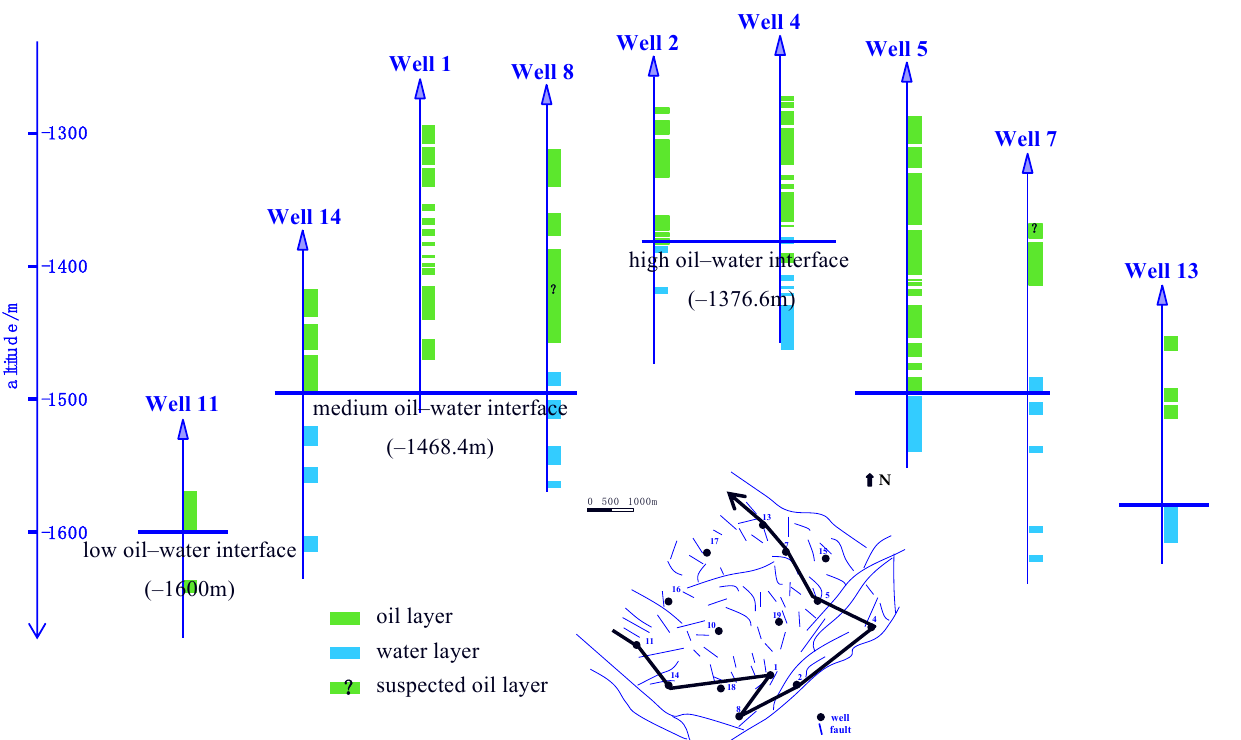
Figure 3. Longitudinal distribution map of oil and water in PL oilfield (OIP oil–water interpretation results). The PL buried − hill reservoir demonstrates a “bulk” bottom water reservoir mode.